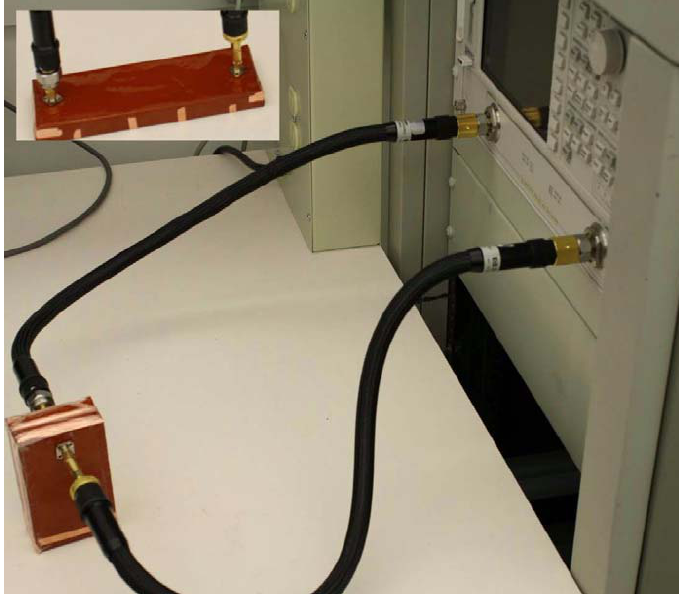
Figure 7. The experimental setup to verify energy tunneling in a wire-loaded waveguide bend. The inset shows the control